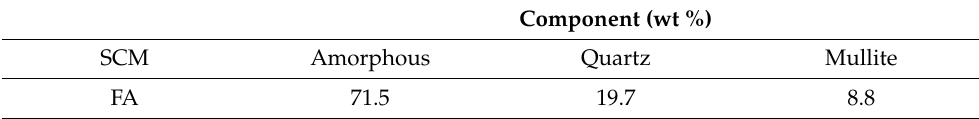
Table 2. Phase composition of fly ash